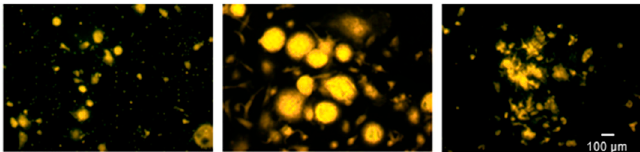
Figure 4. Endogenous phosphatase activity in PBMC -M-CSF/RANKL ( A ), PBMC +M-CSF/RANKL ( B ), and PBMC +M-CSF/RANKL + DMAB (cDMAB) ( C ), all on titanium.